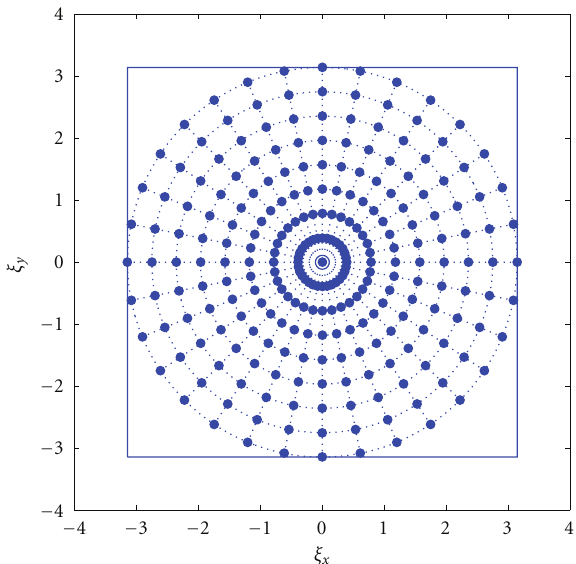
Figure 5: Final Polar grid points after both interpolation processes have been applied. (This figure first appeared in